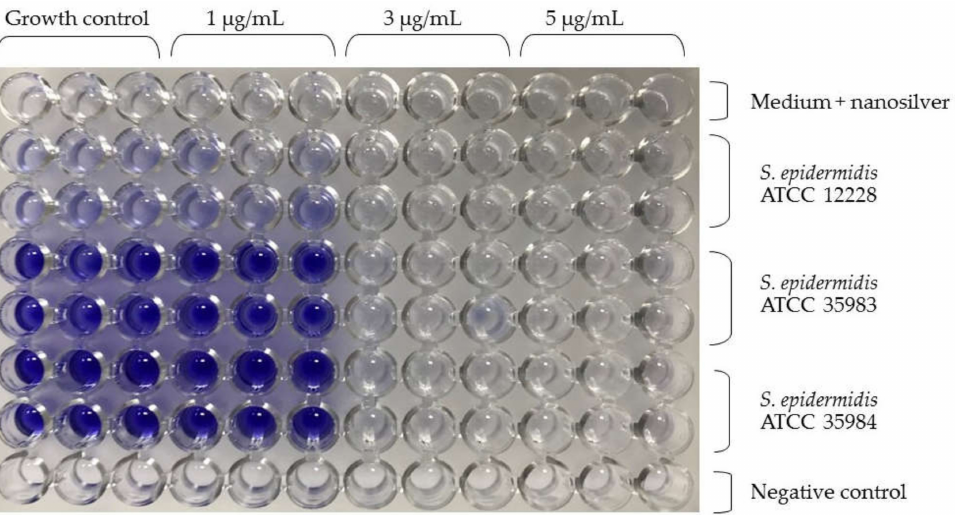
Figure 3. S. epidermidis biofilm formation at different nanosilver concentrations. In the upper part there is a description for nanosilver concentrations in triplicate (1 µ g/mL, 3 µ g/mL, 5 µ g/mL). The side part provides a description for the S. epidermidis strains tested in